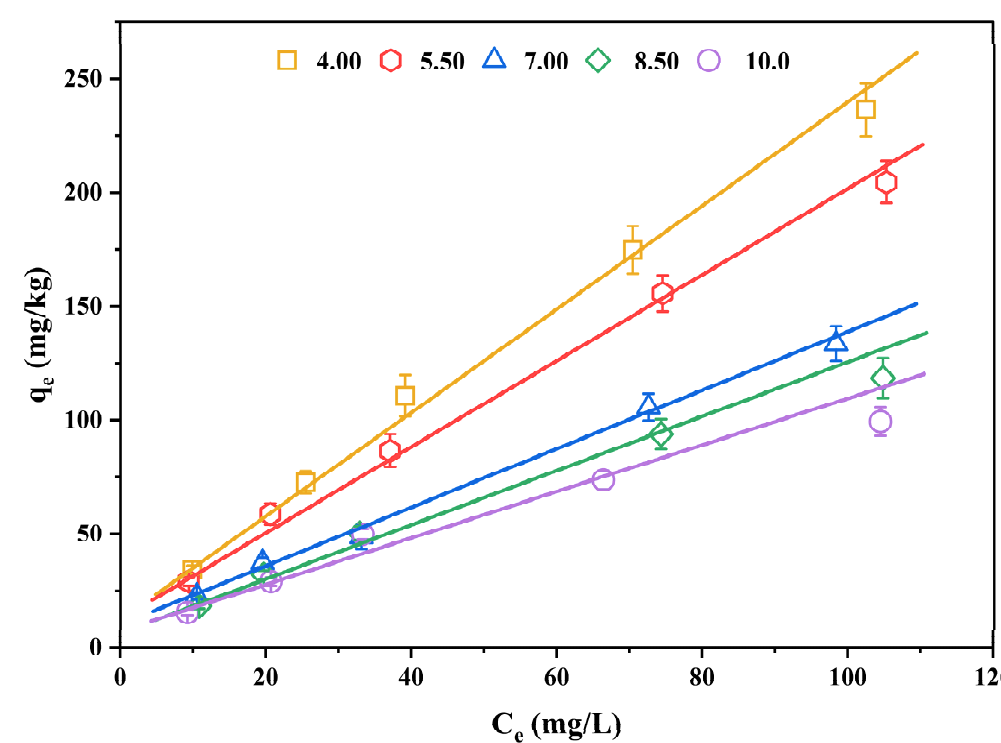
Figure 4. The isothermal sorption curves of 2,3,7,8-TCDT in sediments of the eastern Chaohu Lake at different pH values. Table 4. Freundlich model parameters of 2,3,7,8-TCDT in sediments from the eastern part of Chaohu Lake at different pH values.